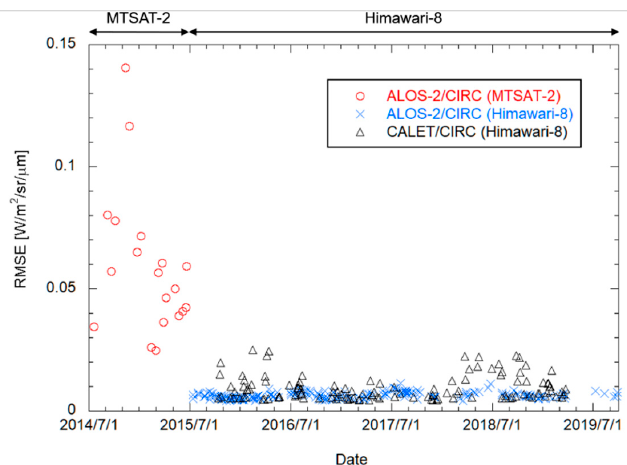
Figure 13. Root mean square (RMS) errors of the AIRS-based regression equations for ALOS-2/CIRC (MTSAT-2 and Himawari-8) and CALET/CIRC (Himawari-8) as a function of date.